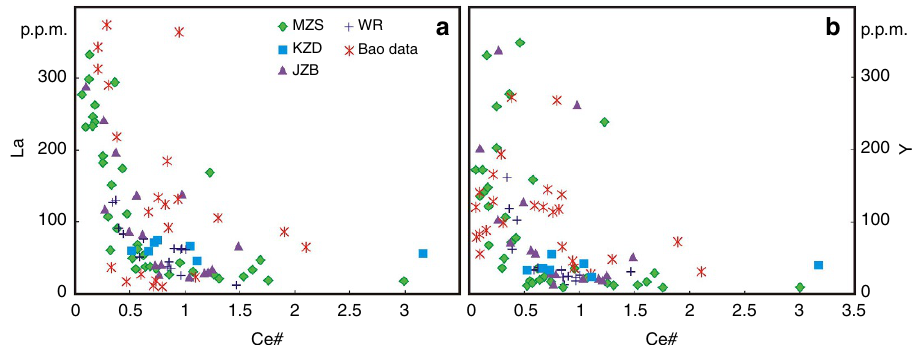
Figure 1 | Diagram showing La and Y compositional change with Ce anomaly for weathering profiles and original whole rocks. ( a , b ) Use La and Y as proxies for total light and heavy REE, respectively. Both La and Yconcentration increases as Ce# (chondrite normalized Ce anomaly: Ce CN /(La CN *Pr CN ) 1/2 ) decreases. Coloured symbols: weathering profiles from MZS (Muzishan), KZD (Kaizidong), JZB (Jiazibei), and original whole rocks (WR) from corresponding sites, all in the Zhaibei area. Previous data are from weathering profiles in the Xinxiu, Guposhan, Huashan and Heling areas 14 . NATURE COMMUNICATIONS|8:14598|DOI: